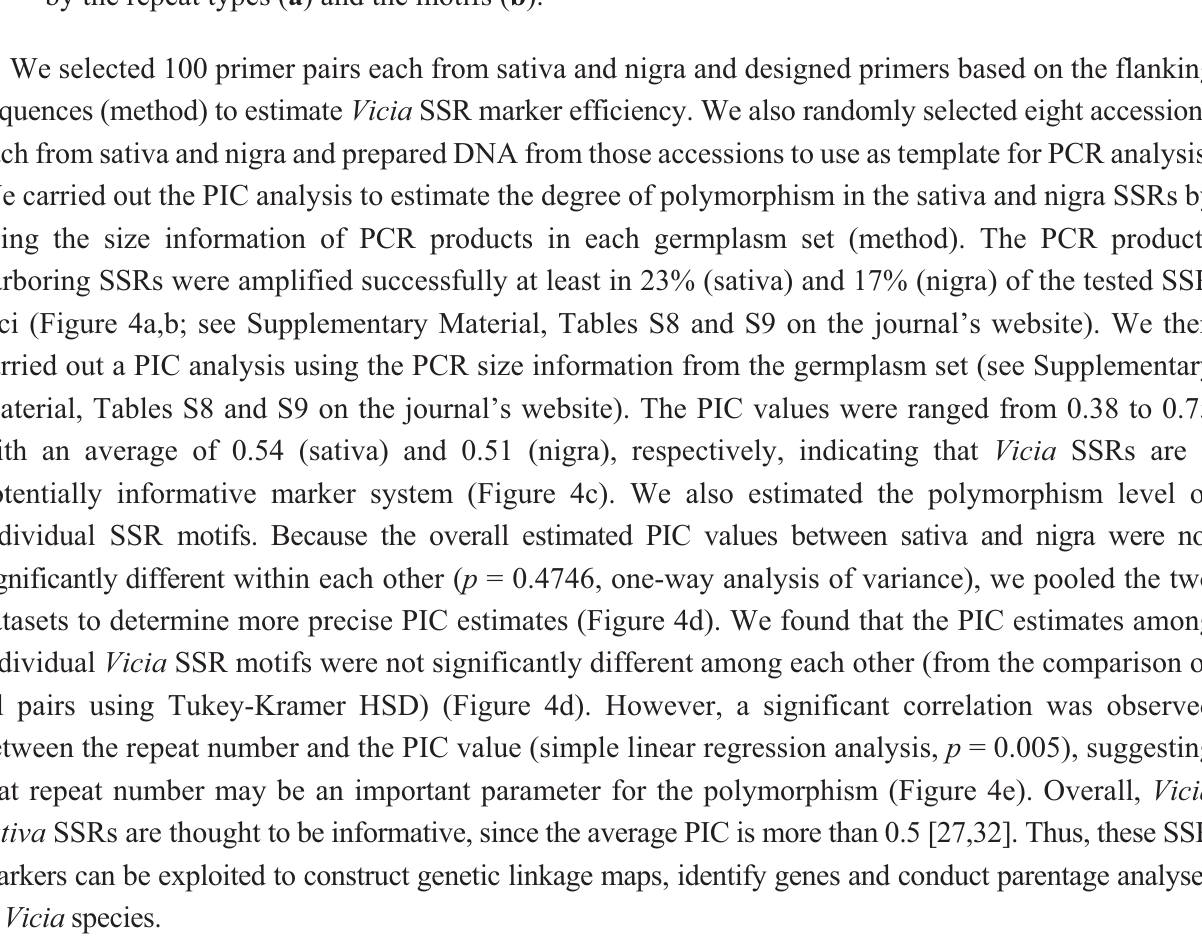
Figure 3. Frequency distribution of SSRs of Vicia sativa nigra and sativa transcriptomes, by the repeat types ( a ) and the motifs ( b